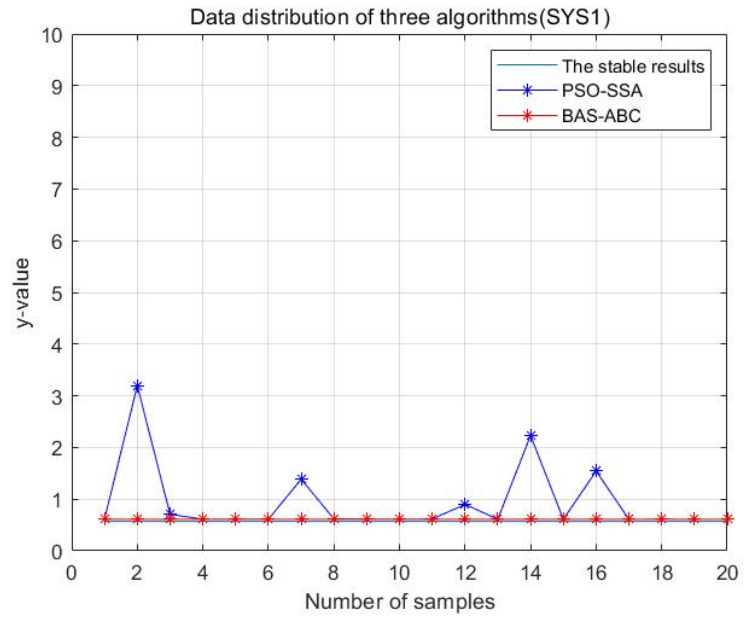
Figure 28. Data distribution—20 of two hybrid algorithms (SYS1).